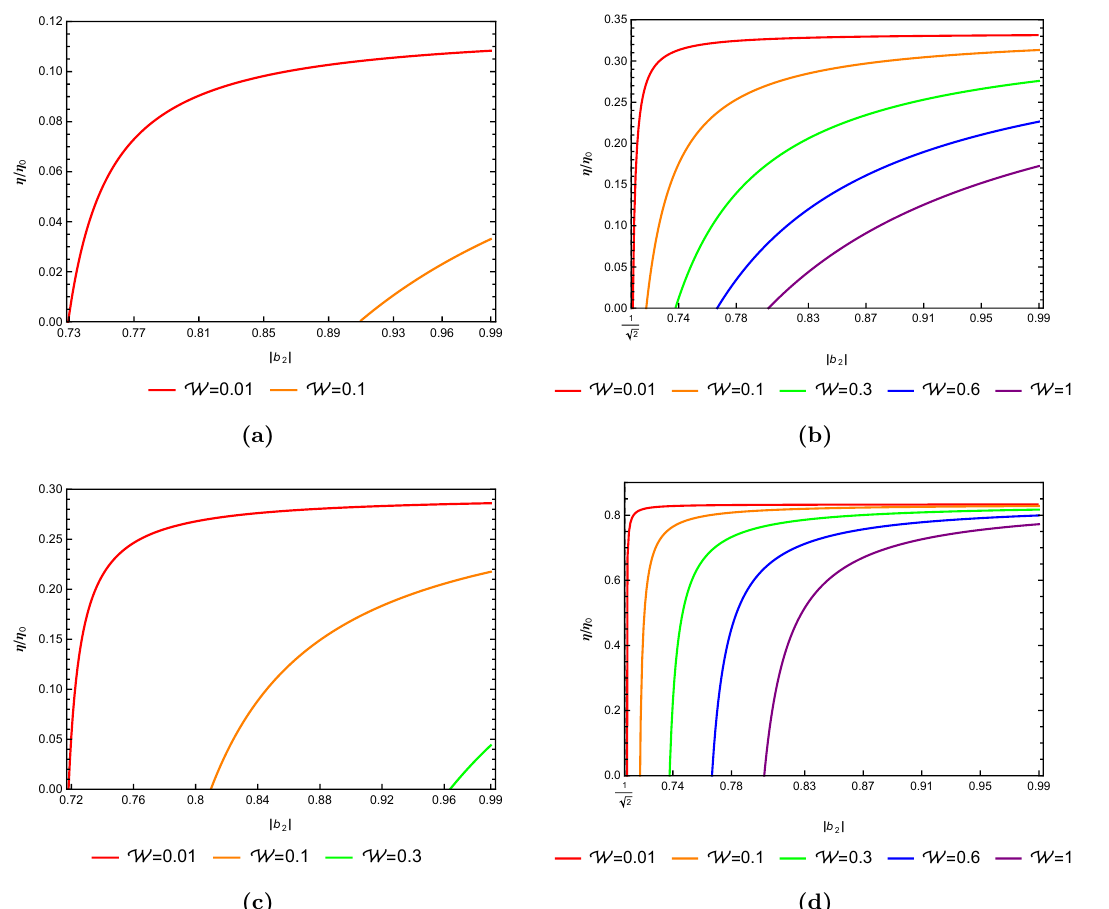
Figure 10. η/η 0 is plotted with respect to | b 2 | for different values of W when the detectors’ in anti-parallel motion: for α = 2 . 0 , plots (a) and (b) are showing this for A = 0 . 5 and A = 10 . 0 , a H respectively. For α = 0 . 2 , plots (c) and (d) are showing the same for A = 0 . 5 and A = 10 . 0 , a H